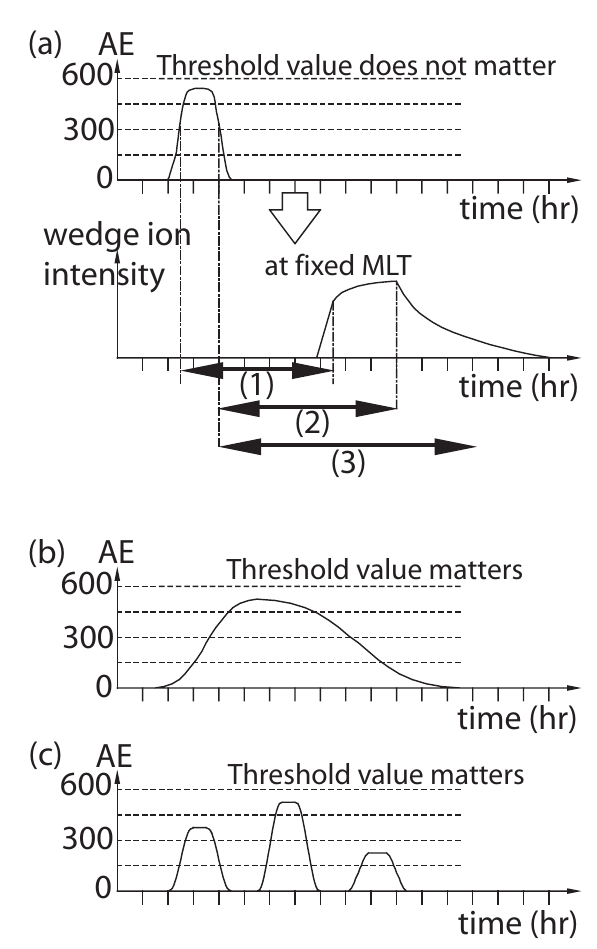
Fig. 3. Illustration of simplified histories of the hot plasma injec- tion from the nightside, as characterized by AE , and the expected intensity of the wedge-like structure in the dayside at a fixed local time. (a) The ideal case is that only one isolated substorm occurred within 1 day before the traversal, and that the substorm duration is shorter than the drift time. (b) The actual increase/decrease of AE can be more gradual, and the injection might gradually increase or decrease. (c) Even worse, we often observe more than two activi- ties with short quiet intervals in between. The arrows in (a) indicates three characteristic times to be considered: (1) drift time of the in- jected sub-keV ions; (2) propagation time of the last injected ions; (3) decay time of the sub-keV ions added to (2).